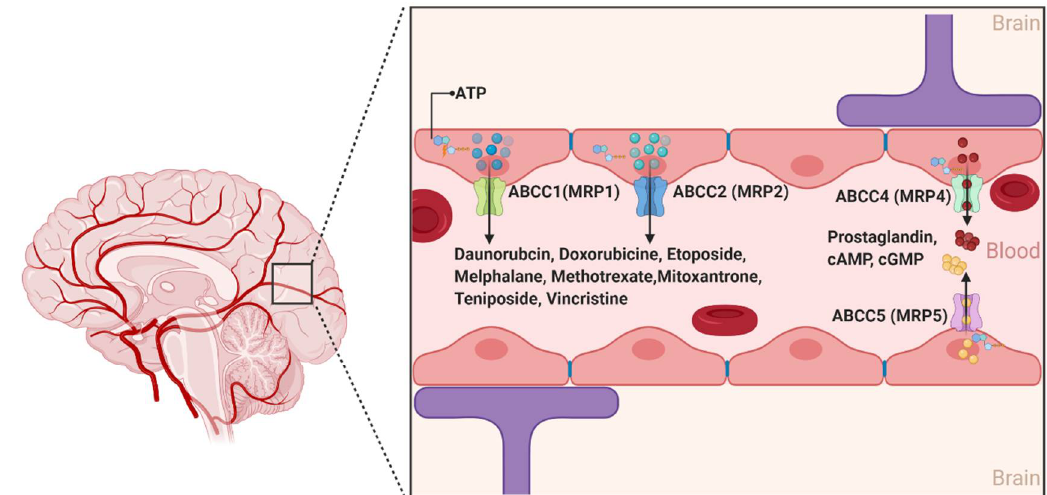
Figure 5. The ABCC transporters at the blood–brain interfaces. In the human brain, ABCC transporters are preferentially expressed on the luminal sides. ABCC proteins are active efflux transporters playing a role in the extrusion of several molecules. (Created with BioRender, accessed on 27 January 2021).